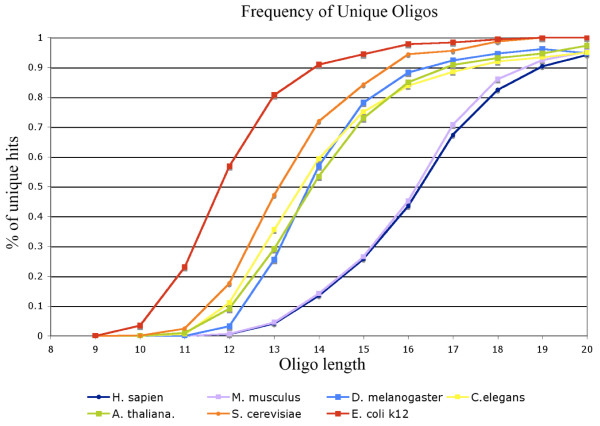
The percentage of n-mers that appeared exactly once (unique hits), out of all the n-mers detected in each genome. Slightly less than 50% of 16-mers detected in humans are unique. Whereas, for E. coli, a little more than 50% of 12-mers were unique.